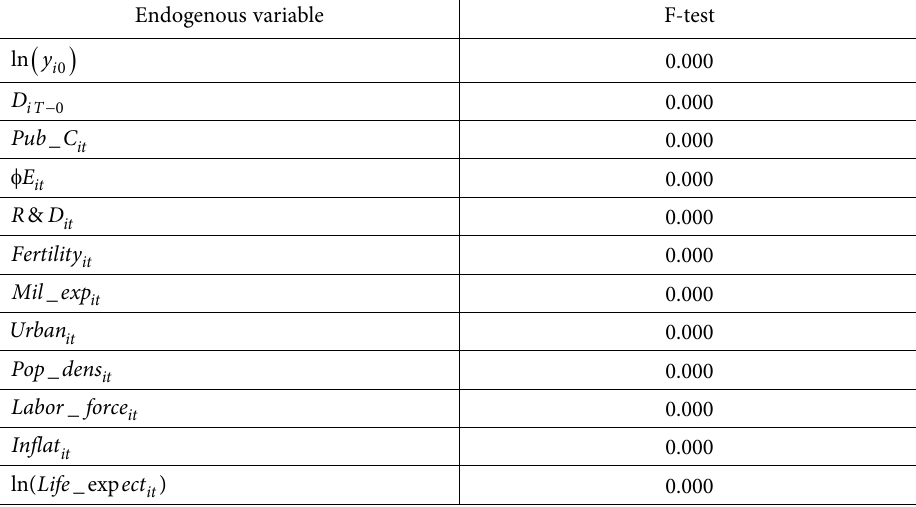
Table A.3. F-test provided for testing validity of instruments for endogenous covariates considered in BPMA (source: By author) Endogenous variable